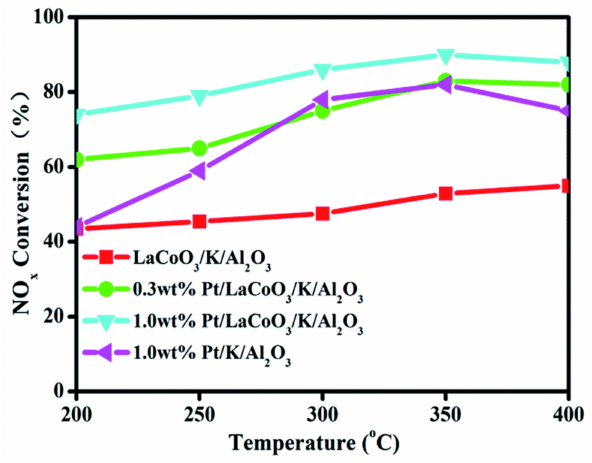
Figure 6. NO x conversion of 1.0 wt.% Pt/K 2 O/Al 2 O 3 and x wt% Pt/LaCoO 3 /K 2 O/Al 2 O 3 . Reprinted with permission from [93]. Copyright 2011, Royal Society of